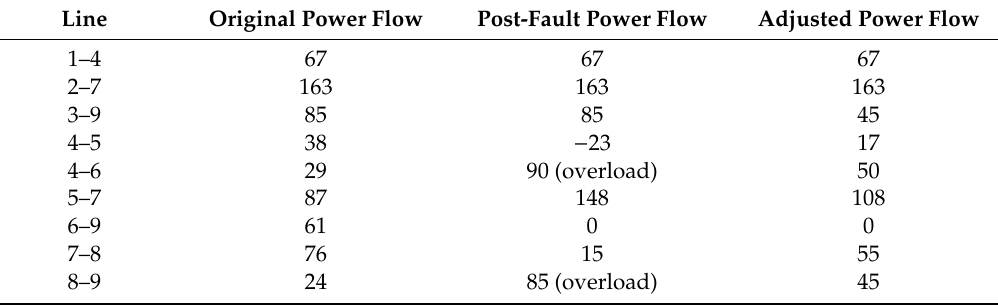
Figure 4. The new stable state of CPPS after the branch fault. Table 1. The power flow transferring under power branch fault